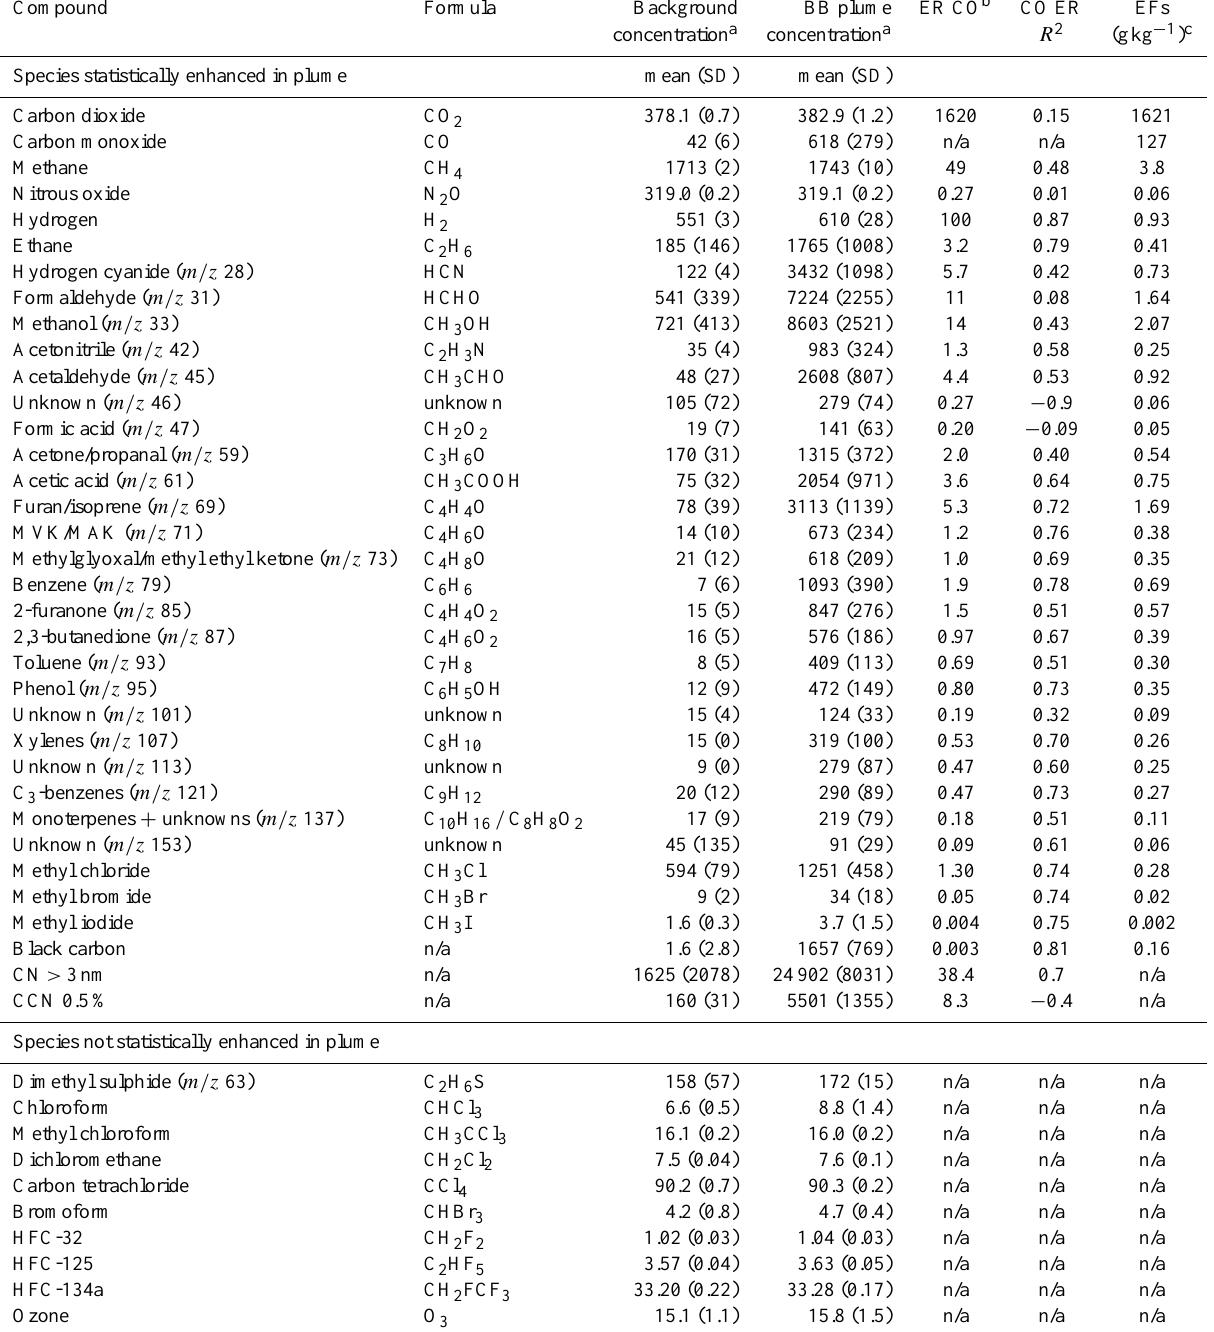
Table 3. Summary of species measured in BB2 coastal heathland fire including background concentration, plume concentration, ER to CO and